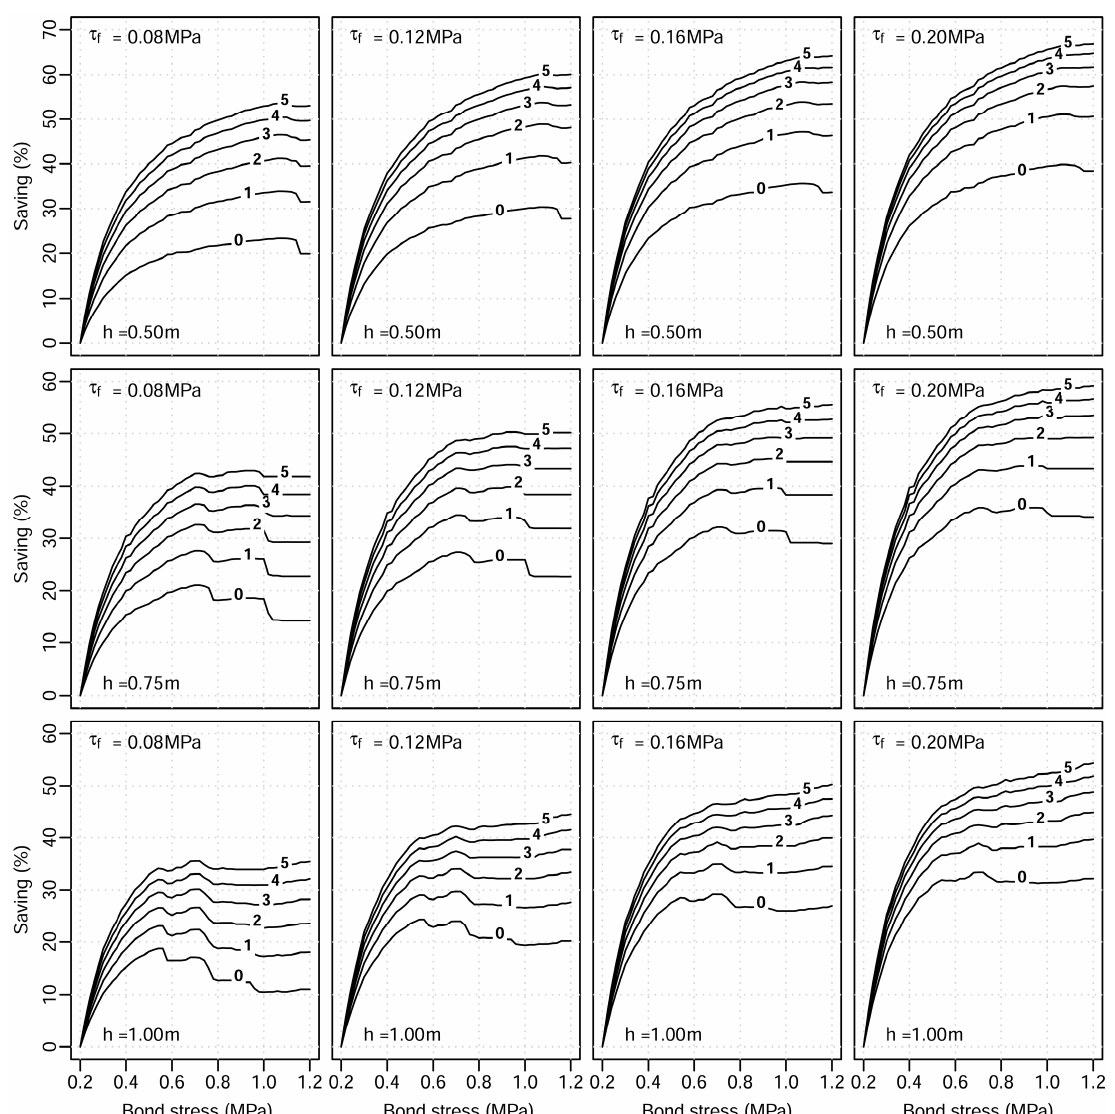
Figure 6. Average savings related to the bond stress (MPa), the thickness of the top non-resistant soil layer (in meters) is the inserted number in the curves, the average side friction stress ( τ f in MPa), and the thickness of the foundation ( h in meters).